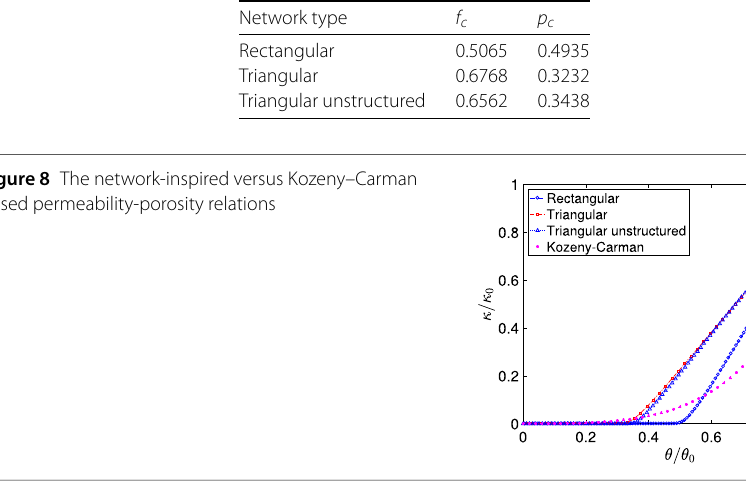
Table 4 The percolation threshold for different network topologies